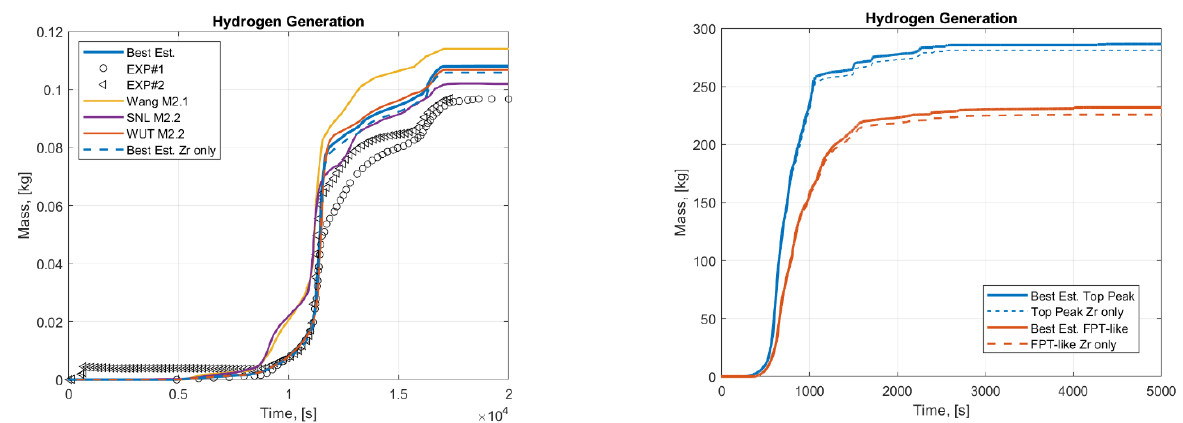
Figure 7. ( Left )—Hydrogen generation best estimate calculations compared with FPT-1 experimental data. EXP#1 is data from ISP46 (SDHD701 sensor). EXP SNL#2 (SDHY700 sensor) alternative data used by SNL. Data taken from [18,29,30,58]. Wang M2.1 results [59,60]; SNL M2.2 [58,61]; WUT M2.2—MELCOR 2.2.11 results from [29]. ( Right )—PWR hydrogen generation for two studied cases and Zr-only generation.